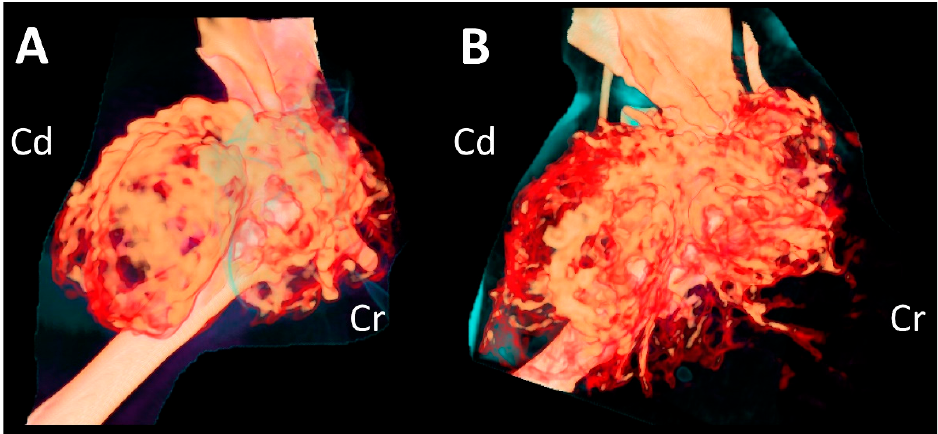
Figure 3. Three-dimensional volume-rendered images of the humeral mass at initial presentation ( A ) and second presentation ( B ), showing increased vascular proliferation around the mass. Amputation of the right forelimb was again strongly recommended, and the owner elected the surgery this time. The right forelimb, scapula, and ipsilateral axillary lymph nodes were removed. Macroscopically, the lesion consisted of a honeycomb structure that contained blood. For histopathological evaluation, tissue samples, including the humeral mass and lymph node, were surgically removed and fixed in 10% neutral-buffered forma- lin. The bone segment was further decalcified by using a decalcifying solution (Sigma- Aldrich, St. Louis, MO, USA) following the manufacturer’s instruction. The tissues were